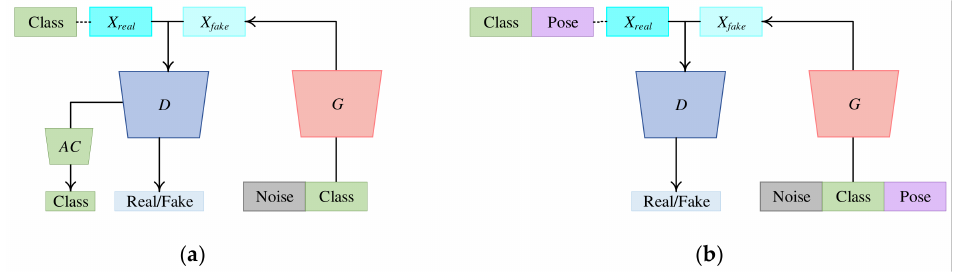
Figure 7. The conceptual architectures of ( a ) modified ACGAN [70] (ACGAN m ) and ( b ) modified CGAN [32] (CGAN m )